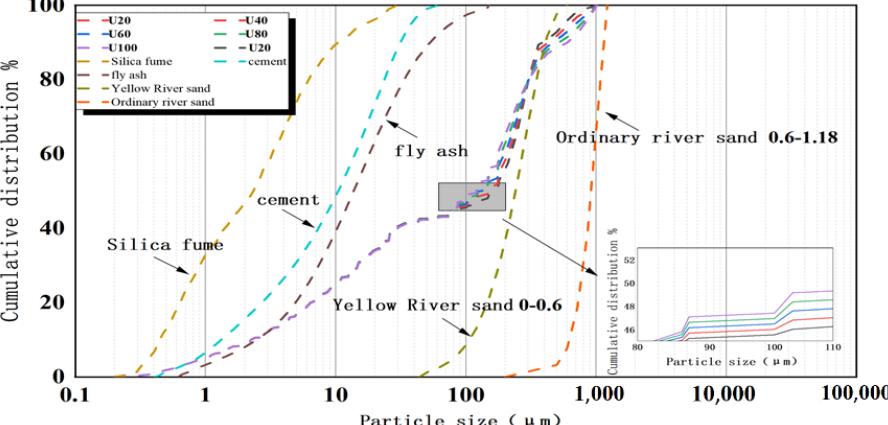
Figure 7. Particle size distribution of raw materials, target curve, and optimization curve of ultra–fine sand mixture of the Yellow River.